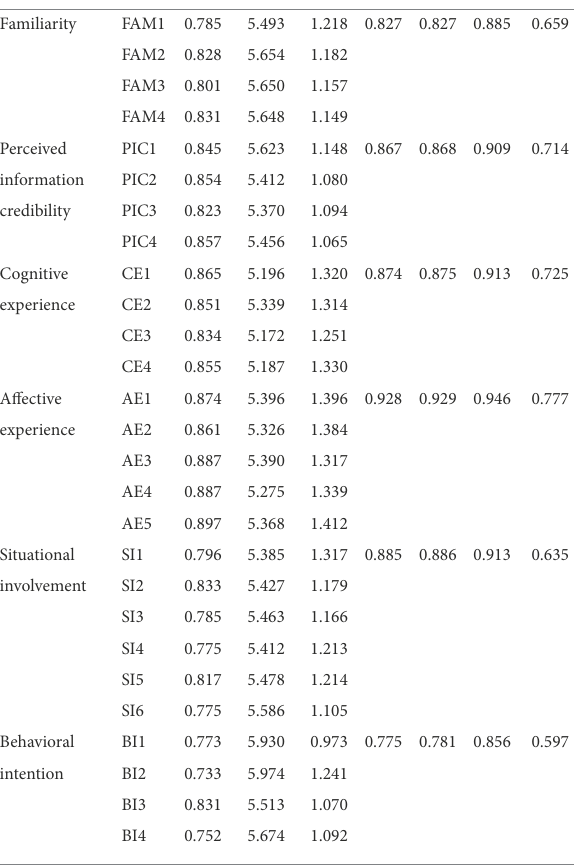
TABLE 3 Reliability and validity or measurement model. Constructs Item